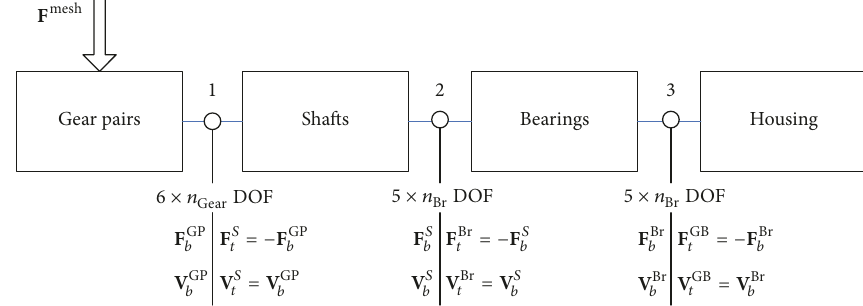
Figure 7: Coupling relationship between